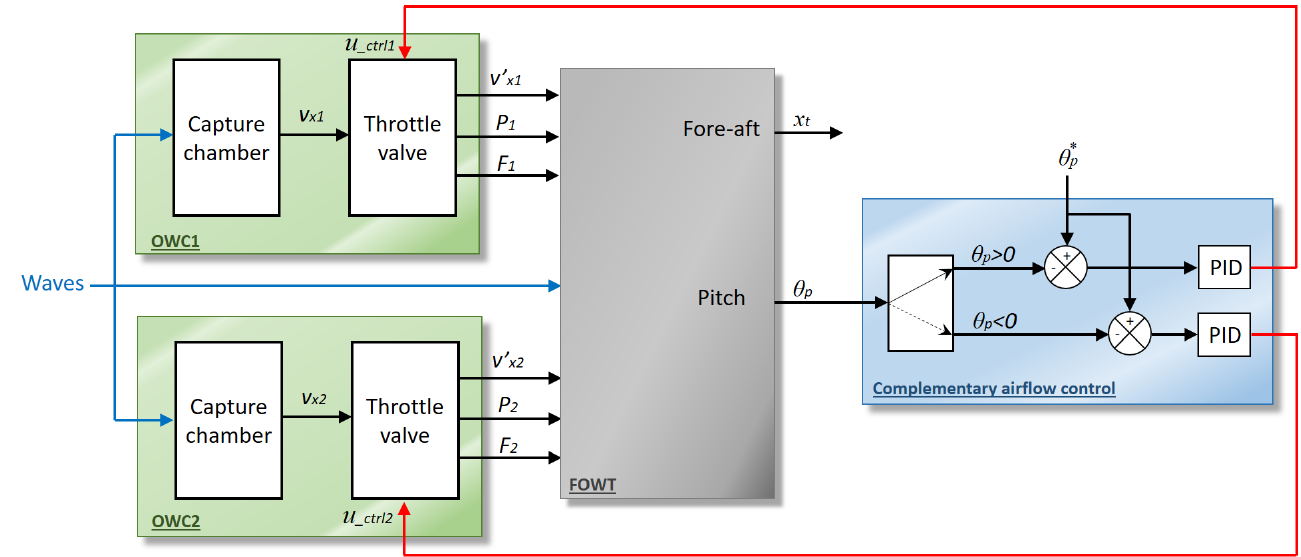
Figure 3. Proposed complementary airflow control for FOWT